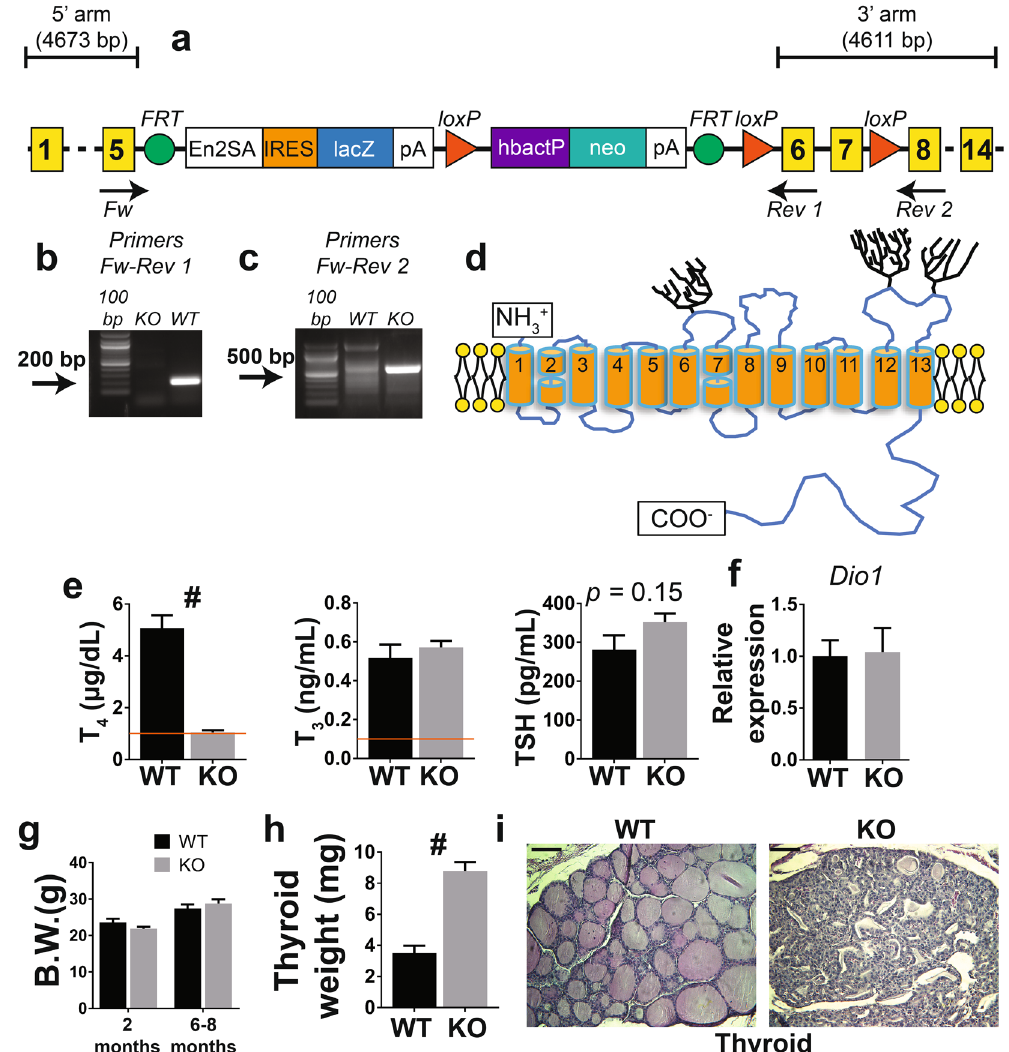
Figure 1. Schematic representation of the targeted region of the Slc5a5 gene, which codes for NIS, and metabolic characterization of WT and NIS KO mice fed a CD. ( a ) The targeted Slc5a5 allele. Yellow squares mark the exons. ( b ) The PCR product obtained using the primers Fw and Rev 1. NIS KO mice, which lack exons 6 and 7, do not show any PCR product, while WT mice show the expected 200 bp amplicon. ( c ) The PCR product obtained using the primers Fw and Rev 2. After FRT and Cre recombination, a 700-bp PCR product is obtained in NIS KO mice, due to the excision of exons 6 and 7. ( d ) NIS secondary structure model showing the 13 transmembrane segments (TMSs) and carbohydrates (trees). The targeted exons (6 and 7) code for TMSs 7 and 8. ( e ) Serum TH and TSH levels in 6–8-month-old male WT and NIS KO mice fed a CD. The horizontal line indicates the detection limit of the T 4 and T 3 ELISA kits (n = 4–5). ( f ) Liver Dio1 mRNA expression levels (n = 5). ( g ) Body weight of male WT and NIS KO mice 2 and 6–8 months old fed a CD (n = 5). ( h ) Thyroid weight of 6–8-month-old male WT and NIS KO mice fed a CD (n = 5). ( i ) Hematoxylin and eosin staining of thyroid sections obtained from the dissected thyroids in h. Scale bar = 50 µ m. En2SA = engrailed 2 gene splice acceptor, IRES = internal ribosome entry site, pA = polyadenylation, hbactP = human beta actin promoter, neo = neomycin resistance. # Indicates p <